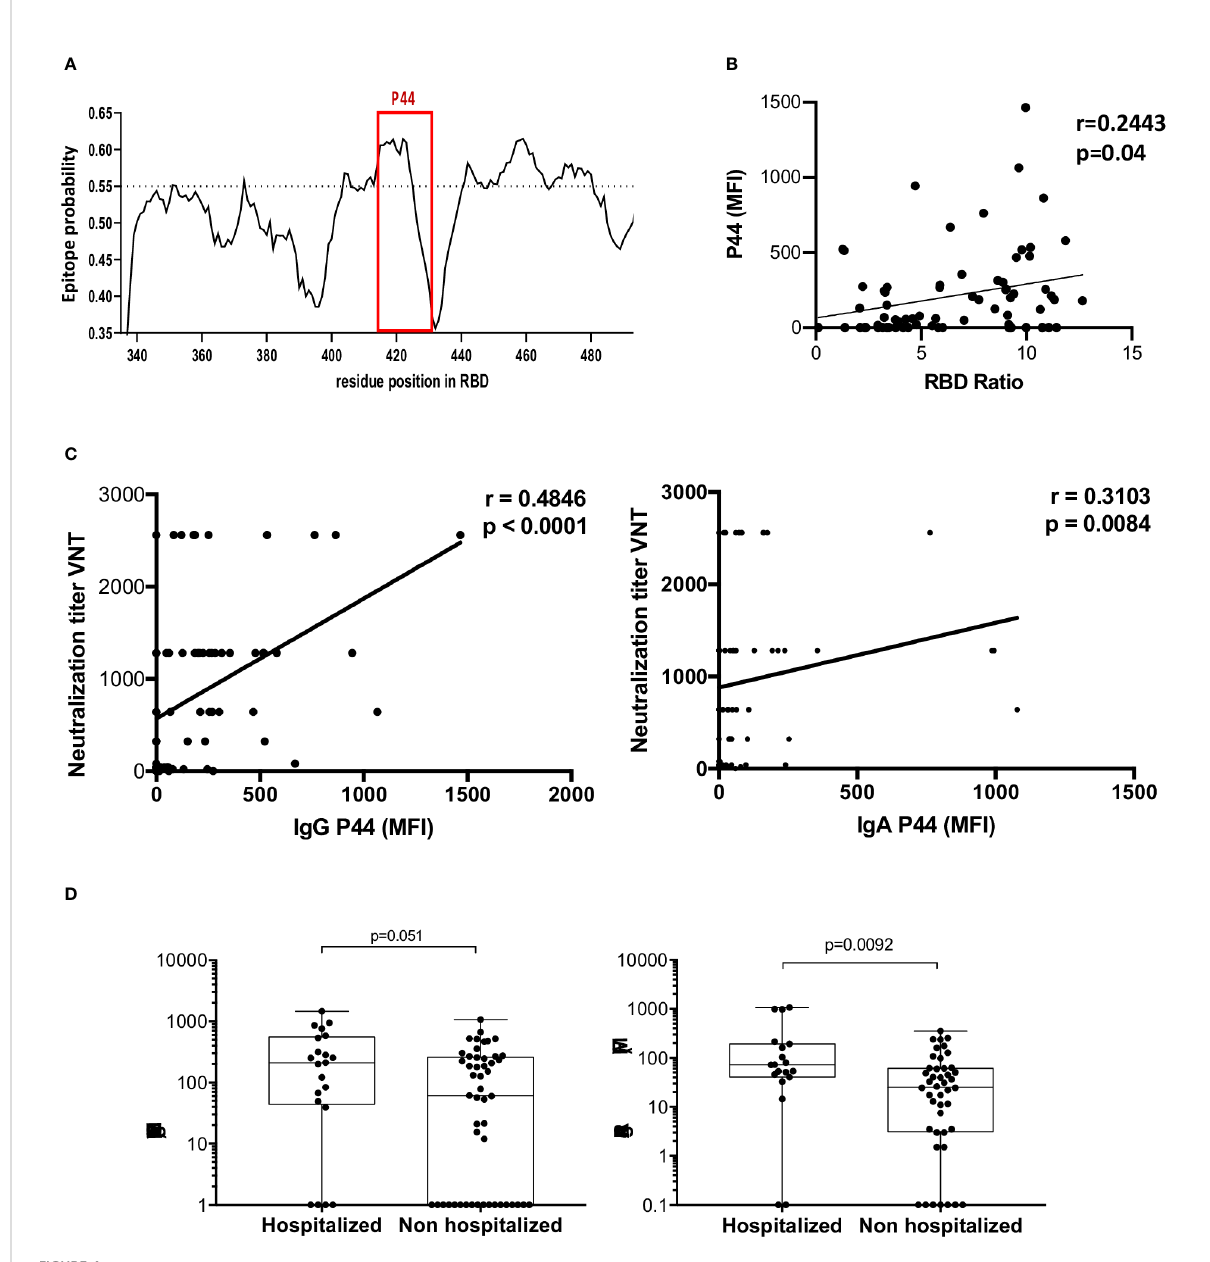
FIGURE 4 Pro fi le of P44 recognition. (A) In silico epitope prediction using BepiPred. Highlighted is the region corresponding to P44, showing a high epitope predictive value. (B) Positive correlation of P44 MFI and RBD IgG recognition in ELISA. (C) Positive correlation of IgG and IgA MFI speci fi c for P44 and virus neutralization titers (Spearman correlation for IgG r= 0.4846, p<0.0001, 95% con fi dence interval 0.2769 - 0.6491, and for IgA r=0.3103, p=0.0084, 95% con fi dence interval 0.07602 - 0.5121). (D) Mean fl uorescence intensity (MFI) of P44 antibody recognition of hospitalized compared to non-hospitalized individuals, showing higher IgA reactivity in hospitalized individuals (p=0.0092, Mann